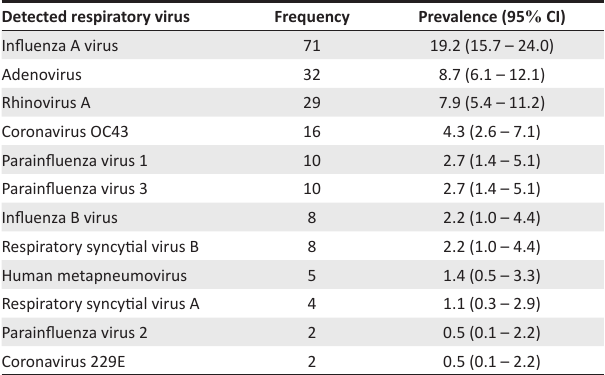
TABLE 2: Frequency and prevalence of respiratory viruses amongst patients presenting with influenza-like illness at Kiswa Health Center and Entebbe Hospital, Uganda, between August 2008 and December 2008; n =